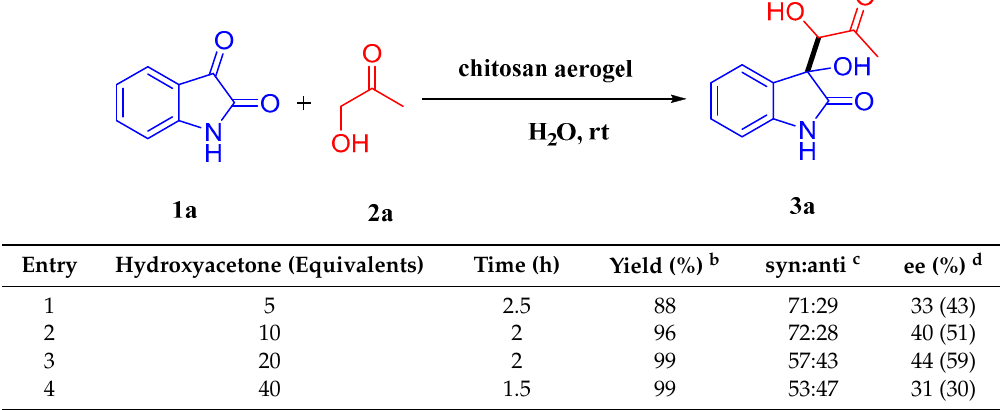
Table 2. Effect of the amount of isatin for the enantioselective aldol reaction in the presence of water a .